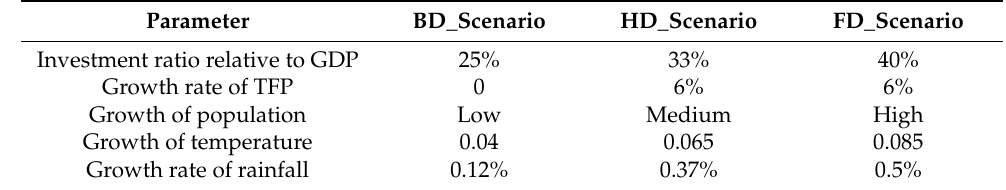
Table 2. Values of different parameters under various scenarios in